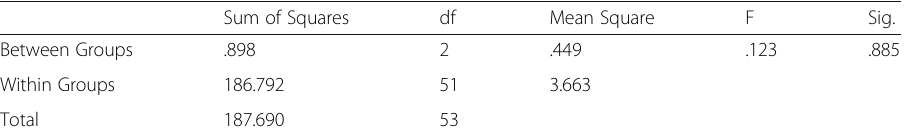
Table 3 One-Way ANOVA (Pre-test) Sum of Squares df Mean Square F Sig. Between Groups .898 Within